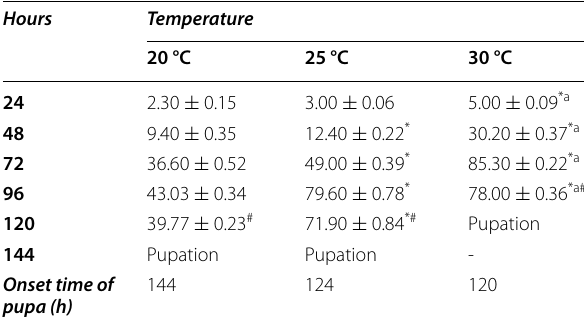
Table 1 Effect of constant temperatures on the average of Chrysomya albiceps larval body weight (mg) (mean different duration s